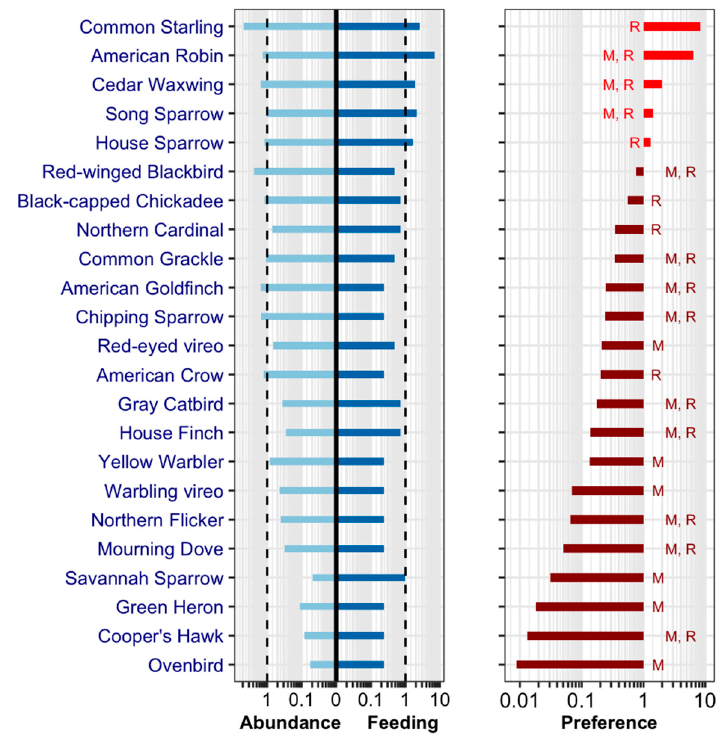
Figure 4. List L 2 : ranked list (n = 23) of bird species found from analysis of Culex pipiens–restuans Figure 4. List 𝐿 (cid:2870) : ranked list ( n = 23) of bird species found from analysis of Culex pipiens–restuans (CPR) blood meals. Left panel: Relative abundance ( n × a s ) of bird species and relative feeding (fraction (CPR) blood meals. Left panel: Relative abundance ( 𝑛 × 𝑎 (cid:3046) ) of bird species and relative feeding of CPR blood meals) ( n × f s ). Dashed vertical lines at relative abundance and feeding “1” represent the (fraction of CPR blood meals) ( 𝑛 × 𝑓 (cid:3046) ). Dashed vertical lines at relative abundance and feeding “1” ratio “1 / n ” where n = 23 is the bird species diversity. Right panel: relative host preference ( n × p s ) of represent the ratio “1/ n ” where n = 23 is the bird species diversity. Right panel: relative host CPR . Quoted letters “M” and “R” stand for migratory and resident birds, preference ( 𝑛 × 𝑝 (cid:3046) ) of CPR . Quoted letters “M” and “R” stand for migratory and resident birds, respectively.